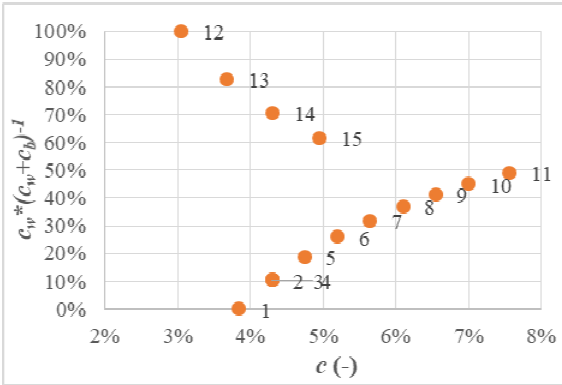
Fig. 2. Order of experiments and proportion of concentration of white particles and total concentrations, numbers in description are order of measurement.